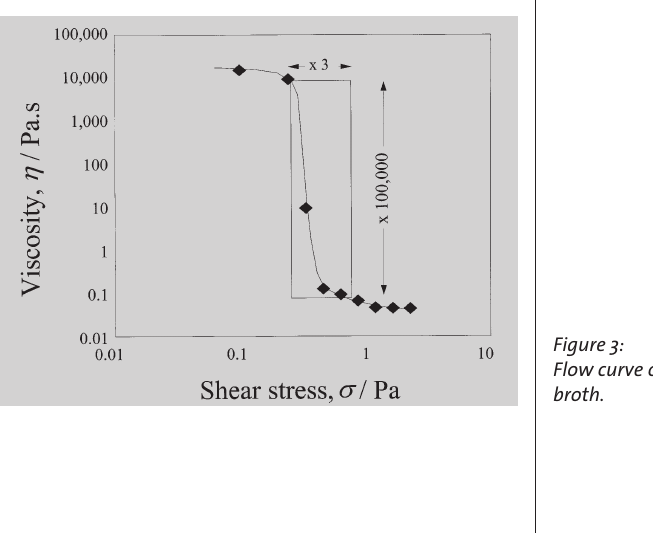
Figure 3: Flow curve of penicillin